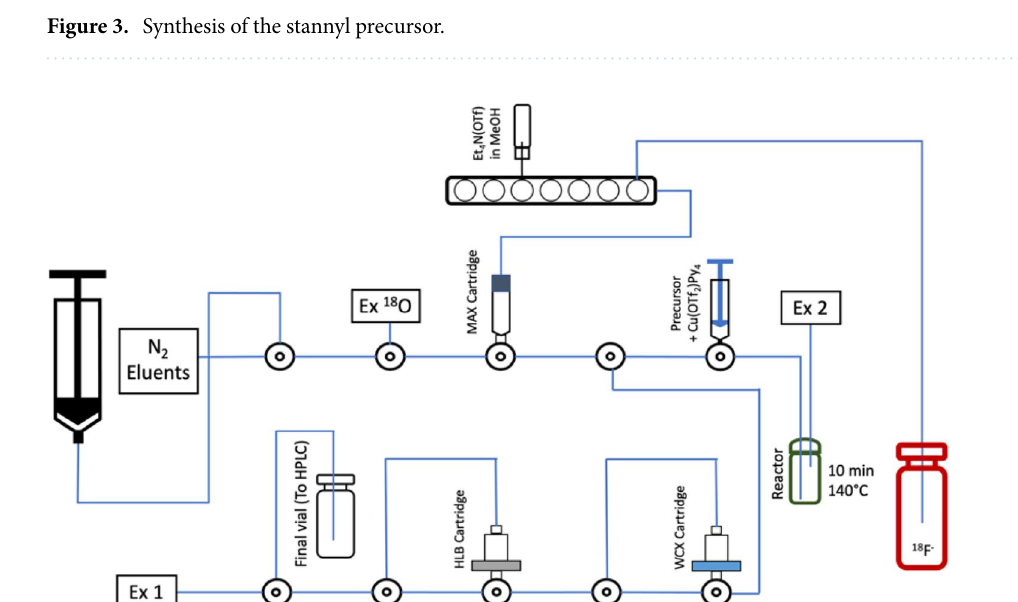
Figure 4. Layout of the module for the synthesis of [ 18